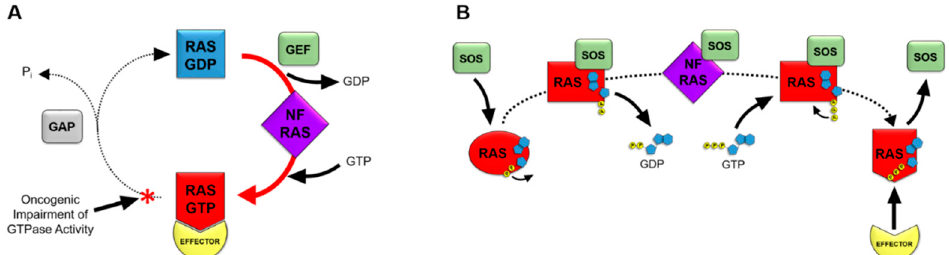
Figure 1. RAS as a molecular switch in the cell. Figure 1 depicts the mechanisms of RAS nucleotide cycling. RAS proteins cycle from an inactive GDP-bound state to a nucleotide-free (NF) transition state, followed by formation of the active GTP-bound state ( A ). Guanine nucleotide exchange factors (GEFs) facilitate the exchange of GDP for GTP. The conformation of RAS is dynamic through this exchange, with GTP-bound RAS being in an active conformation that binds effectors containing RAS binding domains. The intrinsic GTPase activity of RAS hydrolyzes GTP to GDP in order to revert back to the inactive state of RAS. GTPase activating proteins (GAPs) promote GTP hydrolysis activity by approximately 1,000-fold. Oncogenic mutations in RAS genes impair the GTPase activity of RAS, resulting in a prevalence of the active, GTP-bound state of RAS in tumor cells. This portion of the cycle prevalent in oncogenic RAS is depicted with a red arrow and asterisk. SOS mediates the exchange of GDP for GTP on RAS proteins ( B ). SOS binding to RAS results in a conformational shift in RAS, occluding the magnesium cofactor from interacting with the phosphate groups of GDP. The resulting decrease in affinity of RAS for GDP contributes to the release of GDP to form the nucleotide-free (NF) state of RAS. GTP binding to RAS subsequently occurs due to high concentrations of GTP in tumor cells. Initially, only the guanosine and ribose moieties of GTP bind to RAS. Interactions of the gamma phosphate group of GTP with the magnesium cofactor of RAS result in displacement of SOS. The resulting active conformation of GTP-bound RAS can interact with effectors containing RAS binding domains to activate downstream signaling pathways.